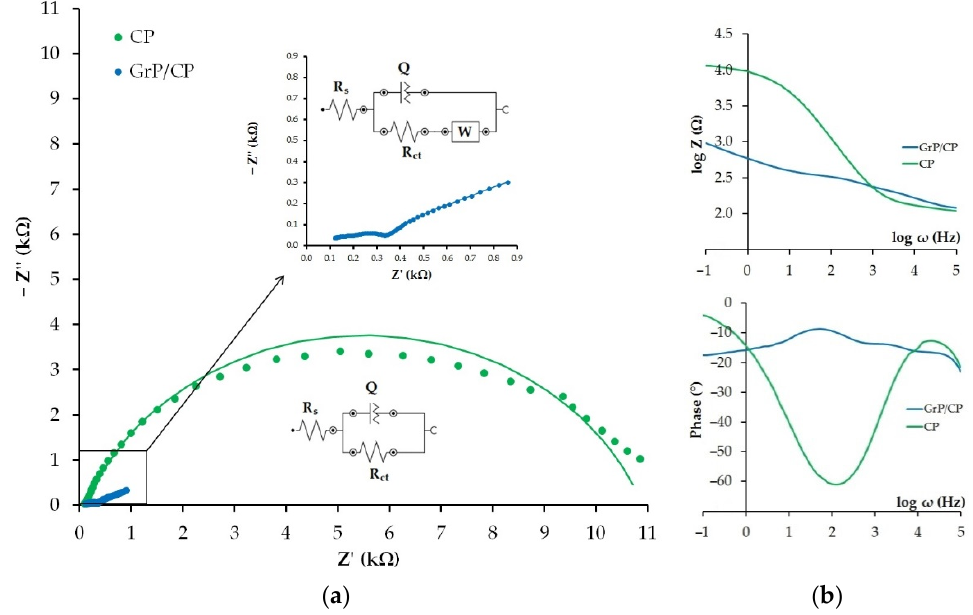
Figure 5. Experimental (points) and fitted (lines) Nyquist plots for CP and GrP/CP electrodes in 0.1 M KCl containing 0.01 M [Fe(CN) 6 ] 3 − /4 − ( a ). Bode plots ( b ). Frequency ( ω ) range 0.1 Hz–100 kHz at polarization potential of 0.2 V. Inserts: Randles equivalent cells.